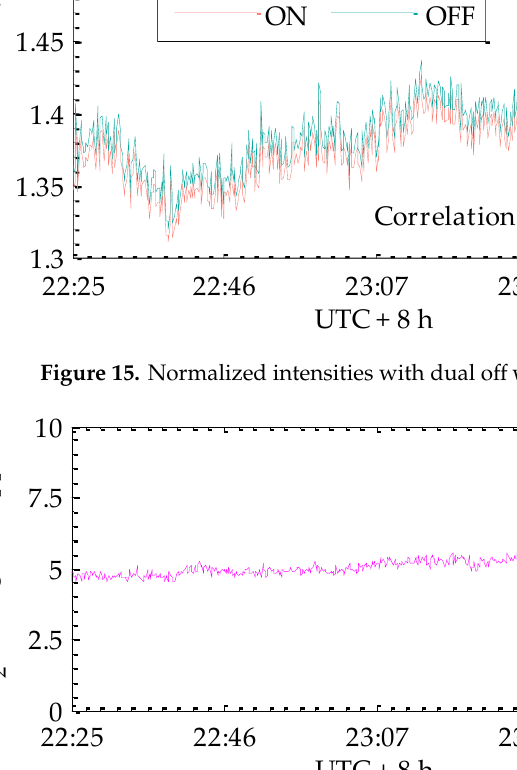
Figure 16. IPDA lidar CO 2 mixing ratio offset measurement using off-off line testing.